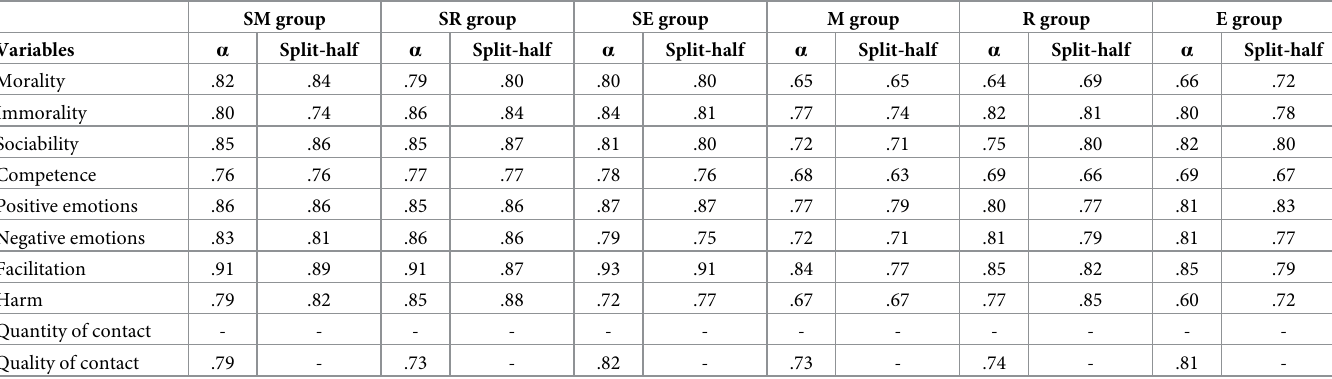
Table 1. Coefficients of estimated reliability (Cronbach’s alpha and Split-half after Spearman-Brown correction) of all the variables in the six sub-samples. SM